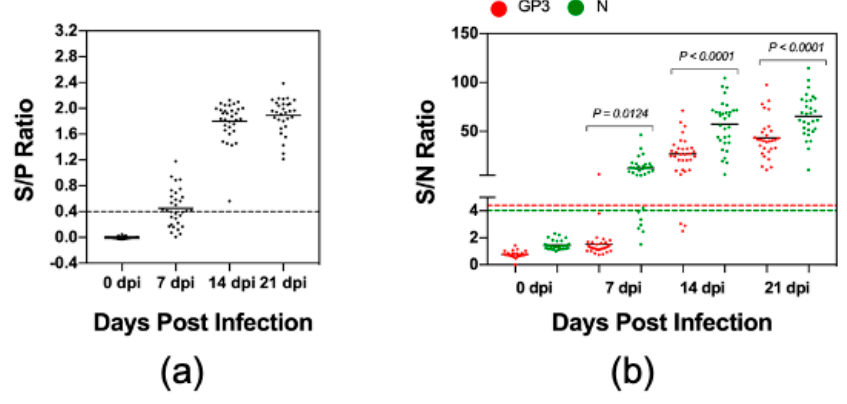
Figure 4. Kinetics of antibody responses to GP3 and N protein. Serum samples were collected from 32 pigs experimentally infected with the PRRSV strain FL12 at 0, 7, 14, and 21 dpi. ( a ) The samples were tested with the IDEXX ELISA. Data are expressed as the sample to positive (S / P) ratios. The horizontal dotted line at S / P = 0.4 indicates the cuto ff of this assay. ( b ) The samples were tested by the LIPS with GP3 and N protein as described in Materials and Method. Fetal bovine serum (FBS) was used as negative control. Data are expressed as sample to negative (S / N) ratios. The dotted lines indicate the cuto ff s of the respective